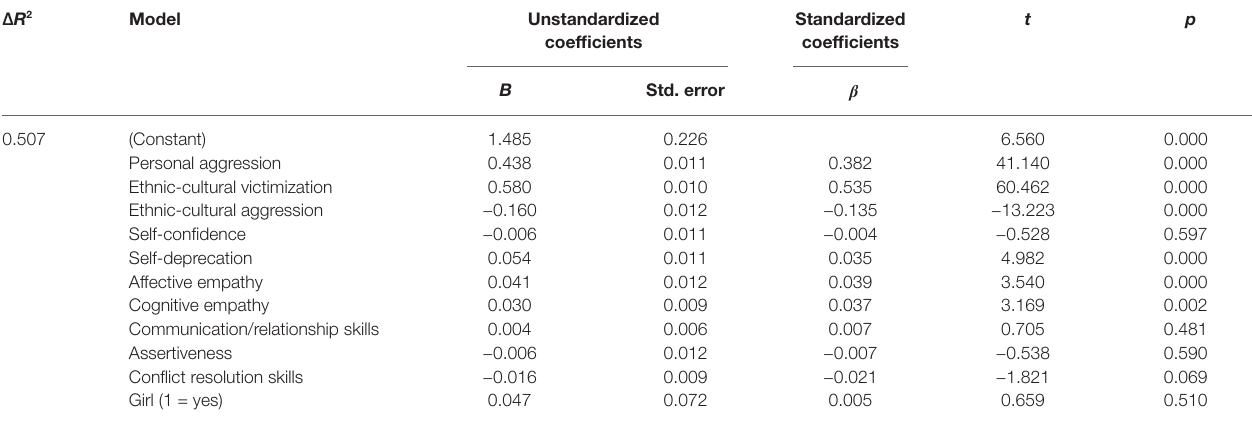
TABLE 2 | Multiple linear regression model for personal victimization (Ecuador). ∆ R 2